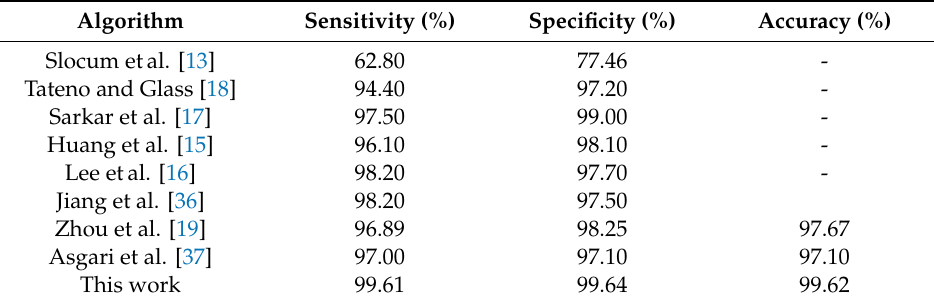
Table 8. Performance comparison of AF detectors on